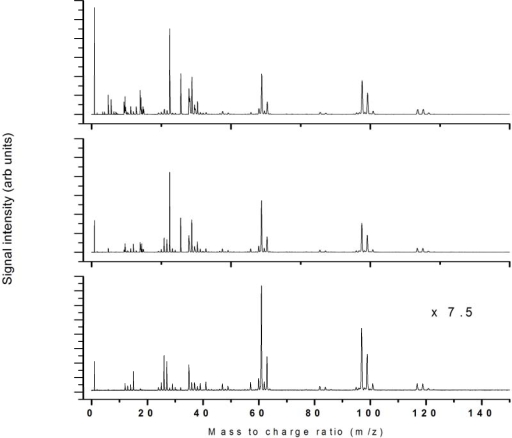
795 nm ionization using 2.3 × 1015 W/cm2, 5.6 × 1014 W/cm2 and 1.3 × 1014 W/cm2.